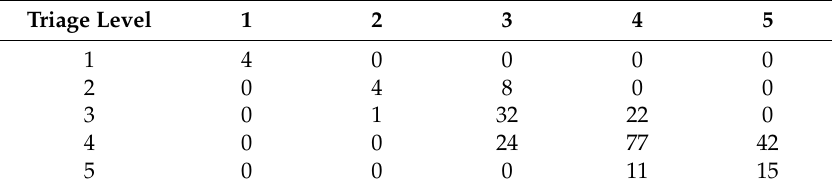
Table 4. Joint distribution of triage classification performed by a nurse using the ESI system and reference standard o ff ered by two physicians independently on the same 240 patients at discharge between July 2016 and July 2017 in the Emergency Service Department of the General Hospital of La Palma. Triage Level 1 2 3 4 5 0